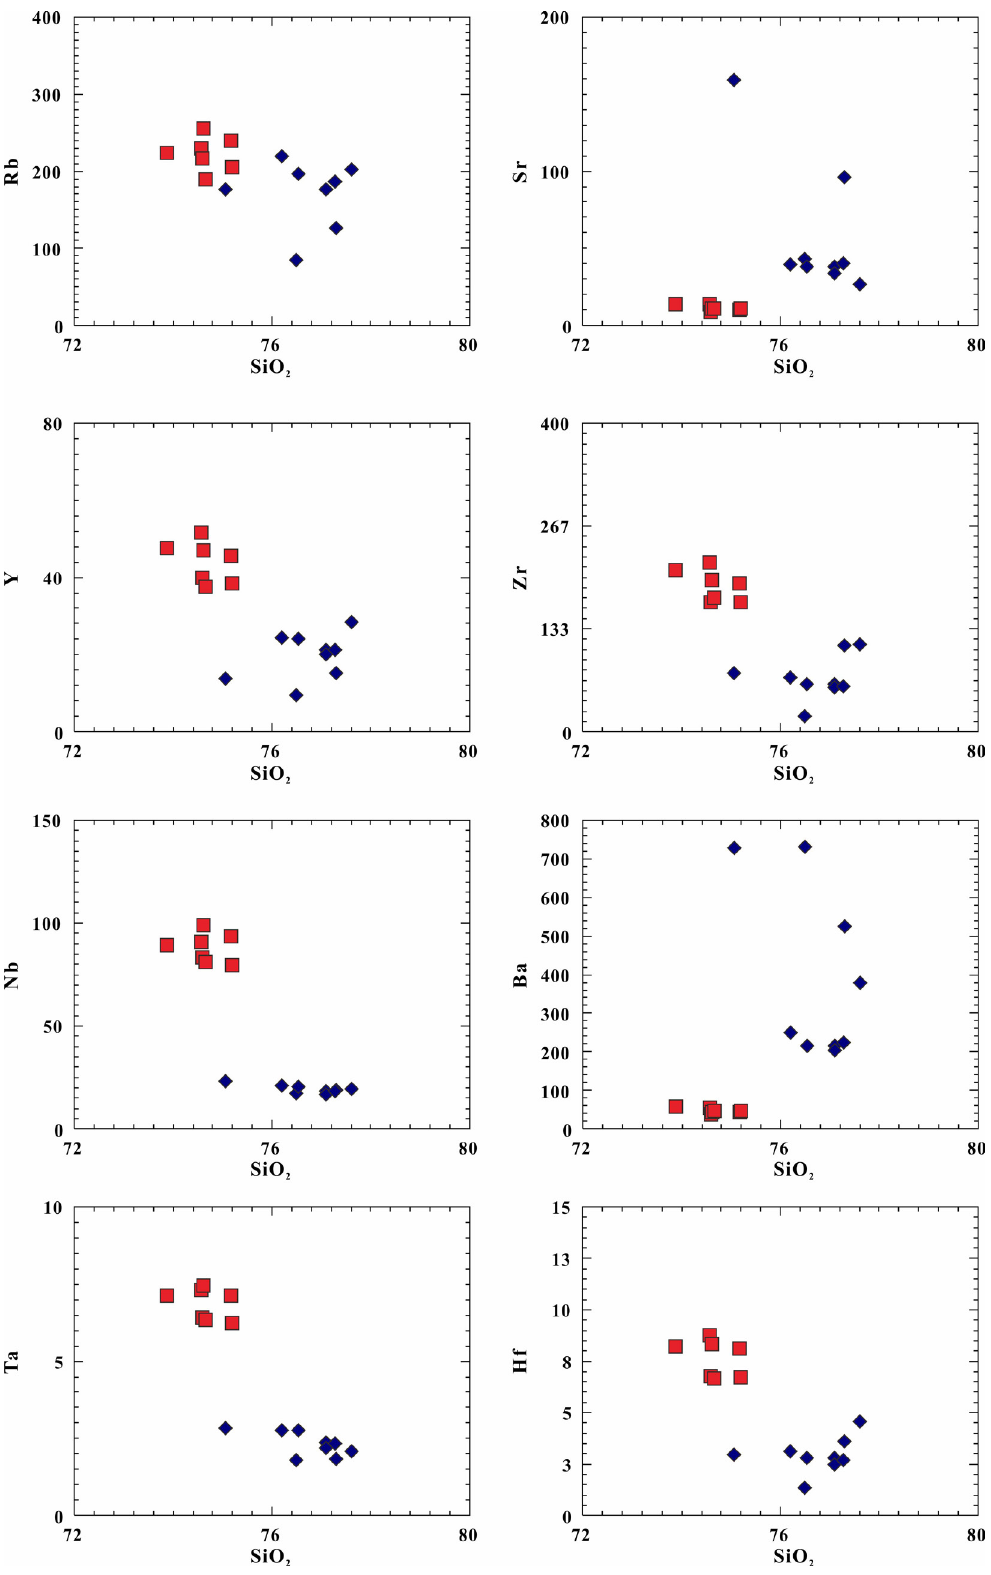
(wt.%) versus trace element contents (ppm) variation diagrams for the Baekdusan and Kyushu obsidians. The Figure 8. SiO 2 symbols are the same as Fig.